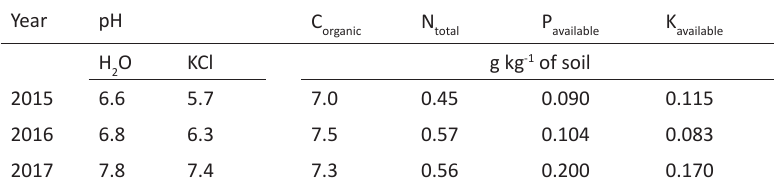
Table 1. Chemical properties of 0–20 cm soil layer of the experimental site in 2015–2017